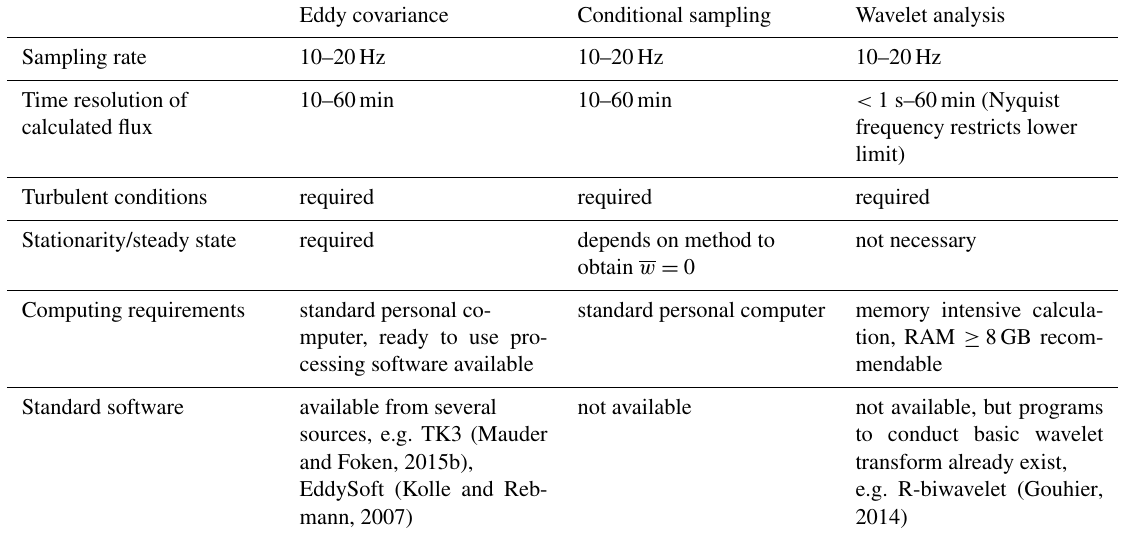
Table 1. Summary evaluation of eddy covariance, conditional sampling and wavelet analysis